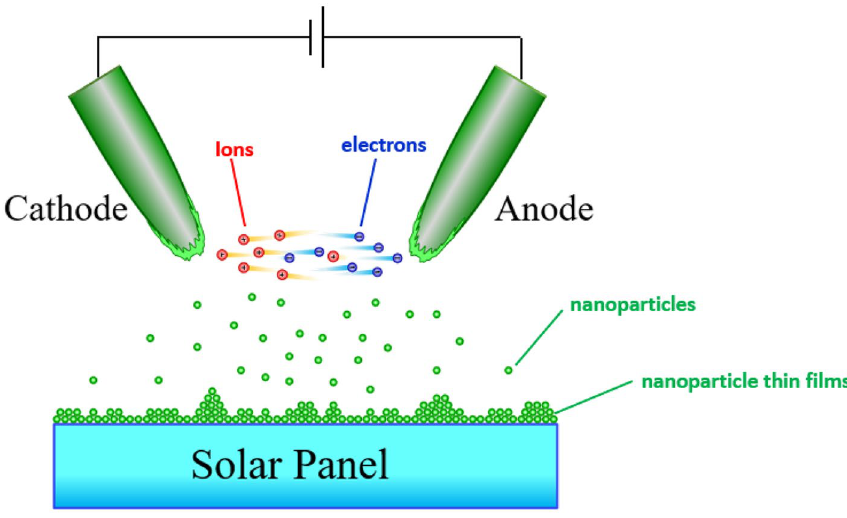
Figure 2. Schematic diagram of the coating mechanism of nanoparticulate films prepared by the sparking